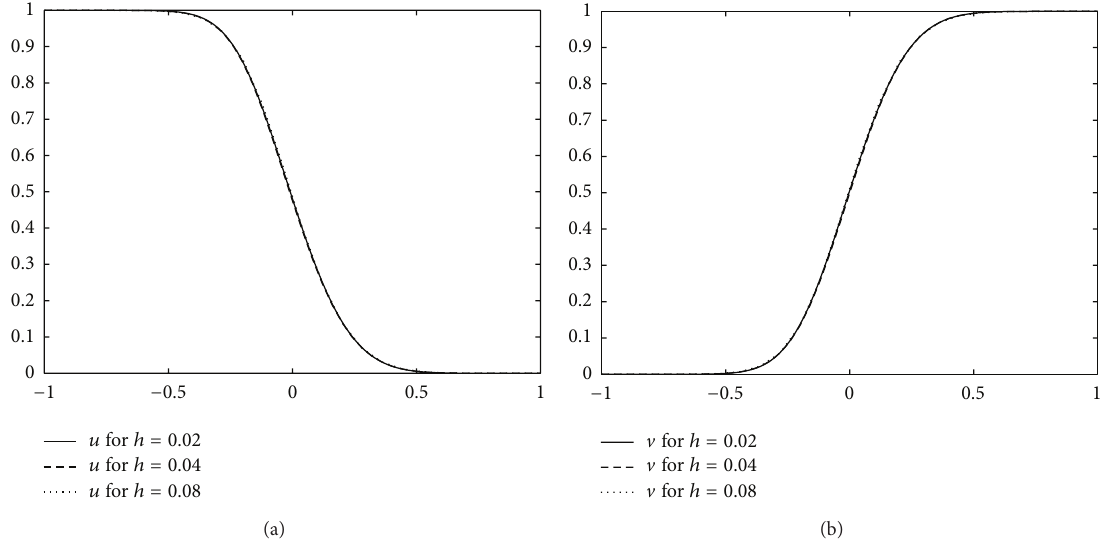
Figure 5: Experimental values of 𝑢 and V for ℎ = .002 , ℎ = .004 , and ℎ = .008 .